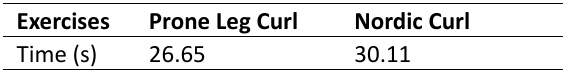
Table 3. Durations of the PLC and NC Exercises